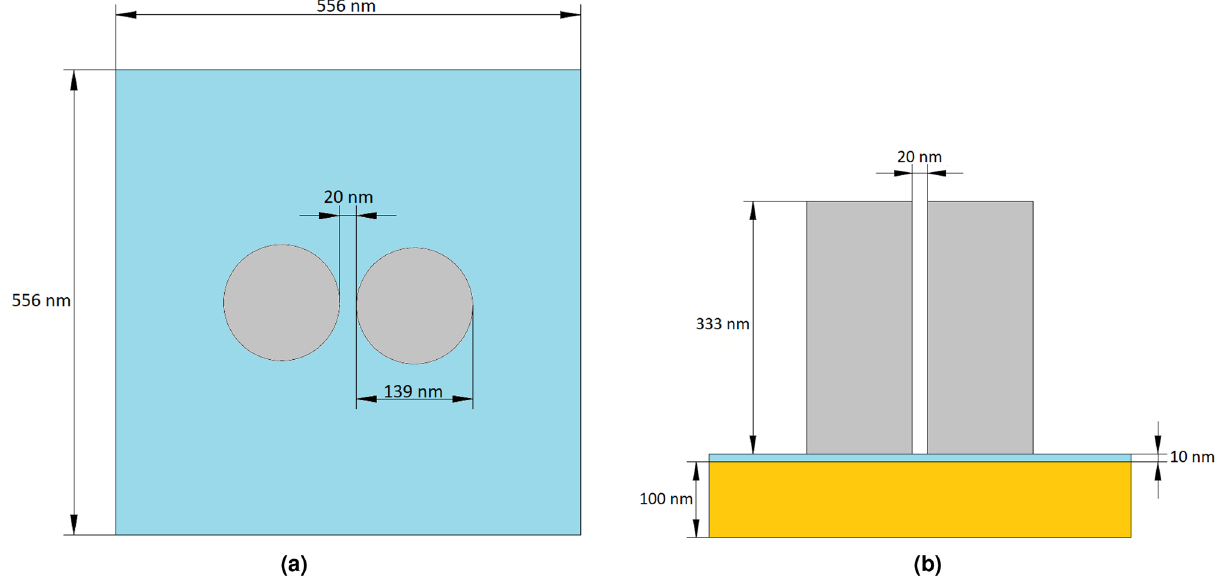
Figure 1. ( a ) Top view of a unit cell of the infinite array employed in numerical simulations. The unit cell (556 × 556 nm) incorporates a dimer consisting of two crystalline silicon pillars separated by a 20 nm gap. The two pillars are symmetrically displaced with respect to the center of the unit cell. ( b ) Side view of a unit cell. The substrate consists of a 10 nm thick fused quartz spacer above a 100 nm thick gold mirror. The array is immersed in water 15